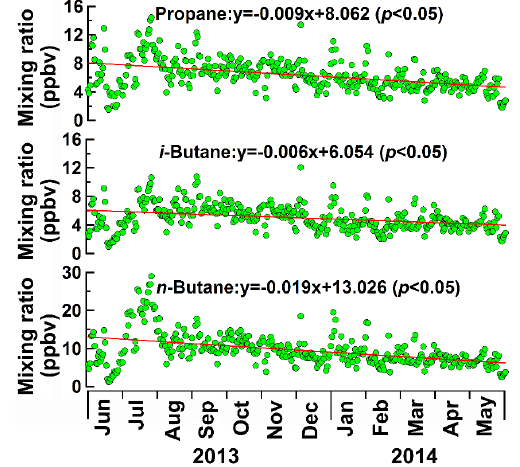
Figure 4. Variation trends of the daily average propane and n/i - butanes at MK from June 2013 to May 2014. In the equation, label x has a unit of